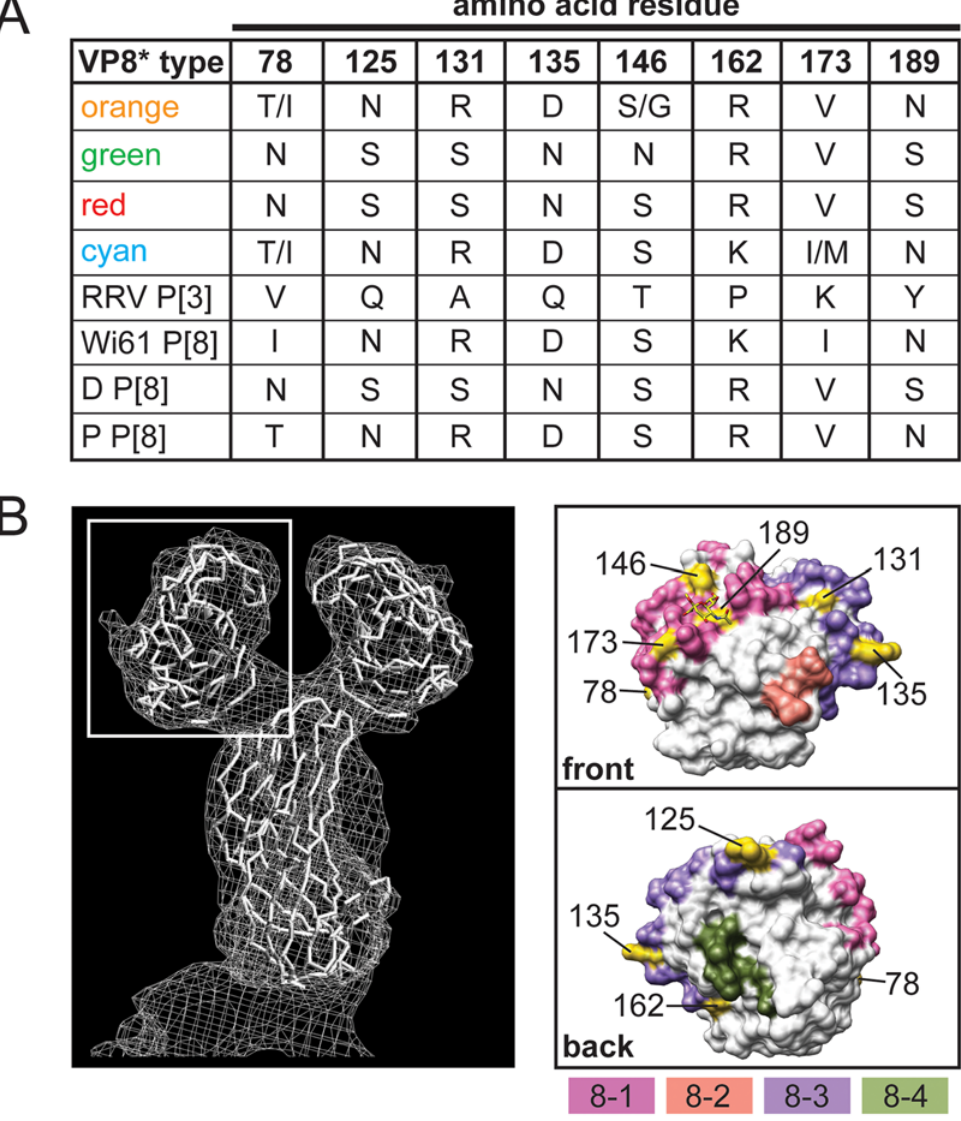
Figure 7. Surface-Exposed Allele-Specific Amino Acid Differences for VP8*. (A) Table of allele-specific differences located on the surface of RRV VP8*. The VP8* type corresponds to the alleles defined in Figure 2 for VP4 (orange, green, red, and cyan), to the P[3] VP4 RRV, or to the P[8] RV strains Wi61, D and P. The amino acid at each position is listed to the right of the VP8* type. Numbering is based on RRV VP4 (GenBank # AY033150). (B) Three-dimensional location of surface-exposed allele-specific differences. The left image shows a surface representation of the VP4 crystal structure (PDB # 1KQR). A white box defines the position of VP8*. The right images show the VP8* core from two different viewpoints (front or back). The front viewpoint is rotated 90 u to the right compared with the image in the white box. The back viewpoint is rotated 180 u to the left compared with the front. Residues comprising the putative neutralization domains of VP8* are listed in Table S4 and have been colored as follows: pink (8-1), salmon (8-2), purple (8-3), and olive (8-4). Allele-specific differences are shown in